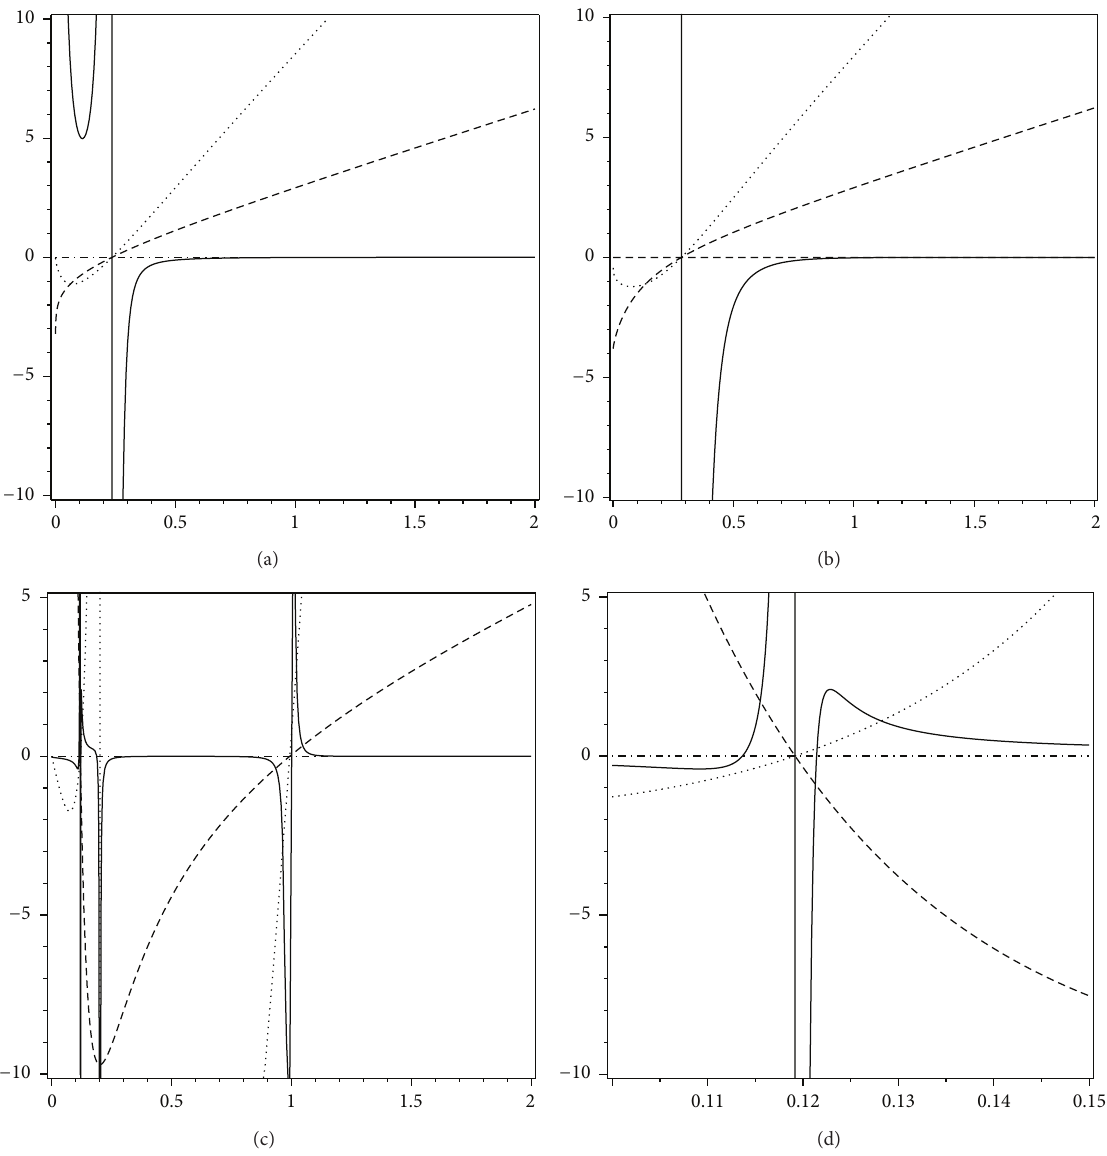
Figure 5: HPEM Ricci scalar (solid line), heat capacity (dotted line), and temperature (dashed line) versus 𝑆 for 𝑙 = 1. HNED model (up-left panel) and SNED model (up-right panel): 𝑞 = 0 . 3, 𝛽 = 1. CNED model (down-left panel) and CNED model (down-right panel): 𝑞 = 1, 𝛼 = 0 . 007 (different